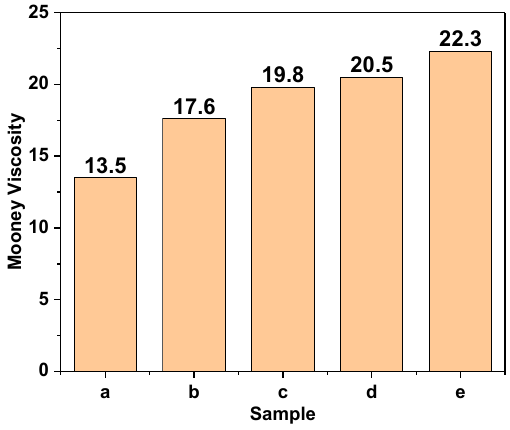
Figure 3. Mooney viscosity of SSC@NR compounds.